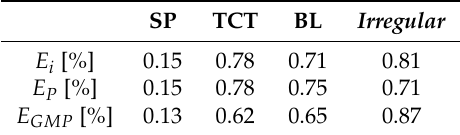
Figure 8. Experimental I-V and P-V curves: ( a ) BL configuration; ( b ) irregular configuration. Table 2. Mean absolute percentage errors for experimental